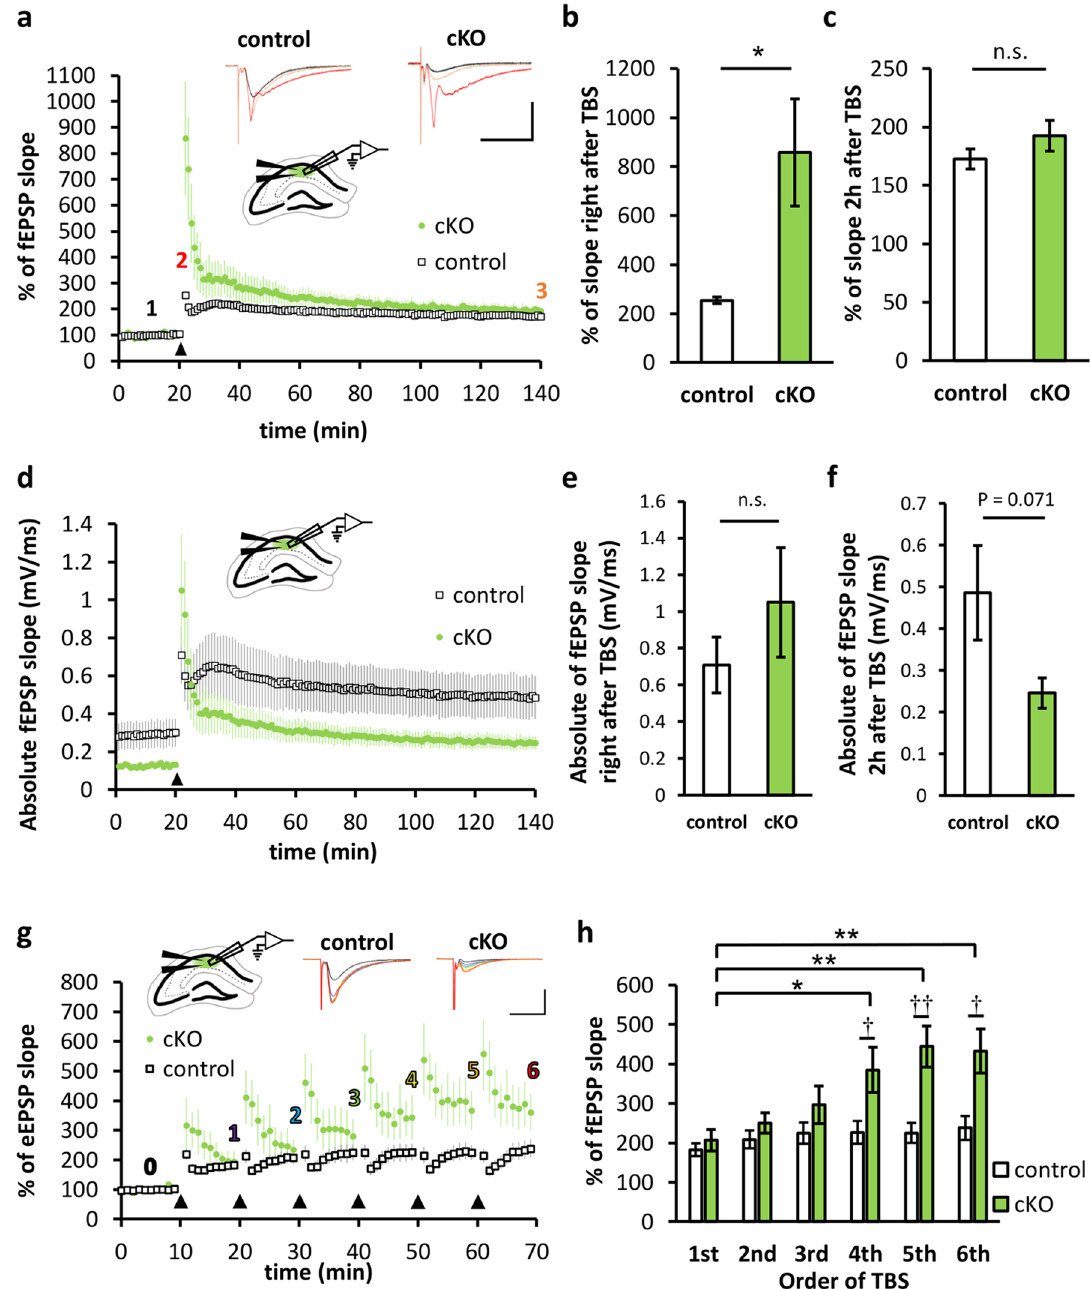
Figure 4. LTP pattern in the CA1 region of Caps1 cKO hippocampal slices. ( a ) Changes in fEPSP slope during LTP induced by TBS in the CA1 region (ratio to the baseline). TBS was applied at the 20 min point (indicated by the black triangle). Representative waveforms recorded at the baseline (black, 1), immediately after TBS (red, 2), and 2 h after TBS (orange, 3) are shown in the top panel (vertical, 2 mV; horizontal, 10 ms). ( b ) Potentiated fEPSP slope levels recorded immediately after TBS in the CA1 region. Control, n = 6 animals; Casp1 cKO, n = 5 animals; P = 0.014, Student’s t -test. ( c ) Potentiated fEPSP slope levels at 2 h after TBS in the CA1 region. Control, n = 6 animals; Casp1 cKO, n = 5 animals; P = 0.222, Student’s t -test. ( d ) Changes in absolute fEPSP slope values during LTP induced by TBS in the CA1 region. TBS was applied at the 20 min point (indicated by the black triangle). ( e ) Absolute value of the fEPSP slope immediately after TBS. Control, n = 6 animals; Casp1 cKO, n = 5 animals; P = 0.314, Student’s t -test. ( f ) Absolute value of the fEPSP slope at 2 h after TBS. Control, n = 6 animals; Casp1 cKO, n = 5 animals; P = 0.071, Student’s t -test. ( g ) Changes in fEPSP slope during LTP induced by repeated TBS at 10 min intervals. TBS was applied at the 10, 20, 30, 40, 50, and 60 min points (indicated by black triangles). The representative waveforms recorded at the baseline (black, 0) and with sustained levels induced by the 1st TBS (purple, 1), 2nd TBS (light blue, 3), 3rd TBS (light green, 3), 4th TBS (yellow, 4), 5th TBS (orange, 5), and 6th TBS (red, 6) are shown in the top panel. Scale bars: vertical, 1 mV; horizontal, 20 ms. (H) Sustained potentiation ratios recorded 10 min after the 1st to the 6th TBS. * P < 0.05, ** P < 0.01; 1st vs. n-th, † P < 0.05; control vs. Caps1 cKO, Student’s t -tests. Number (n) of animals used for statistical analyses in this experiment: n = 5 for control and n = 5 for